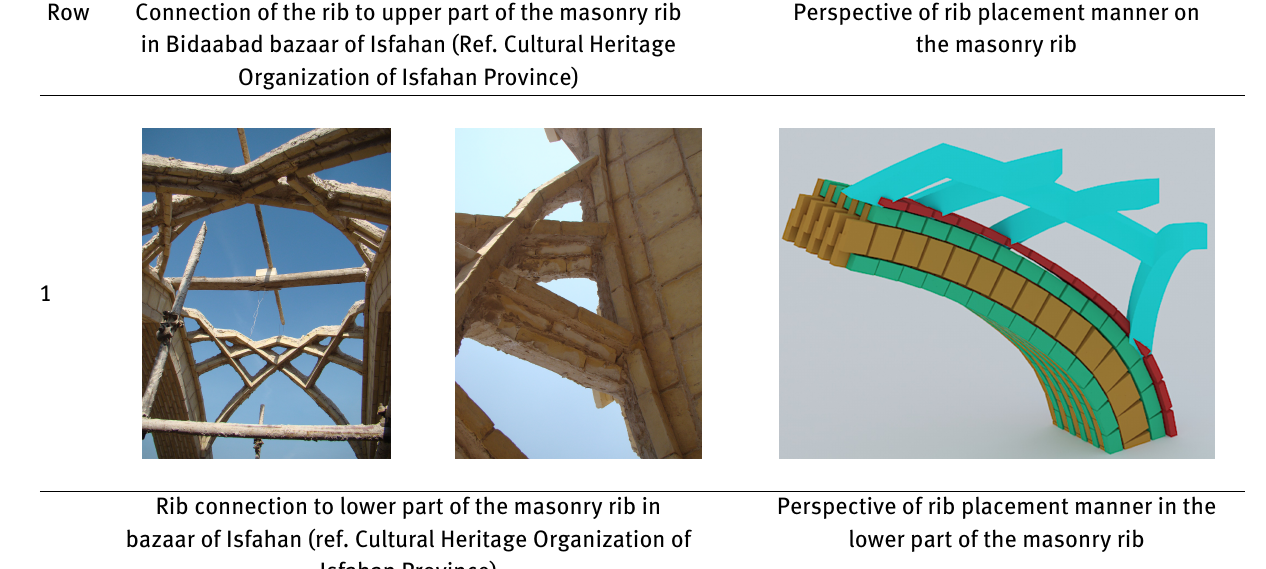
Table 6: Placement manner of Karbandi ribs on the masonry rib Row